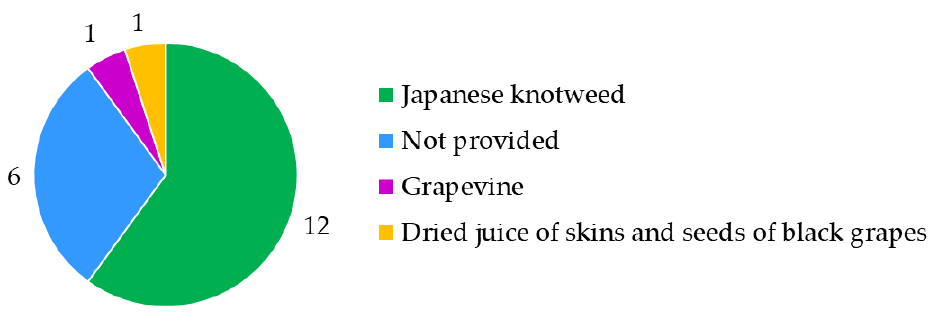
Figure 7. Resveratrol origin declared on food supplements.